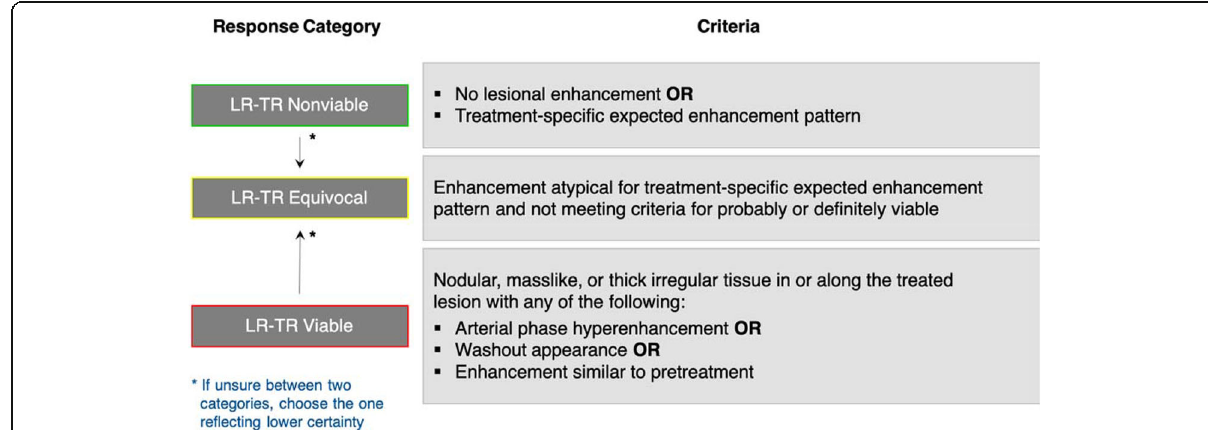
Fig. 2 LI-RADS CT/MRI Treatment Response criteria and tiebreaking rule. Diagram created by authors. Adapted and reprinted, with permission, from ACR